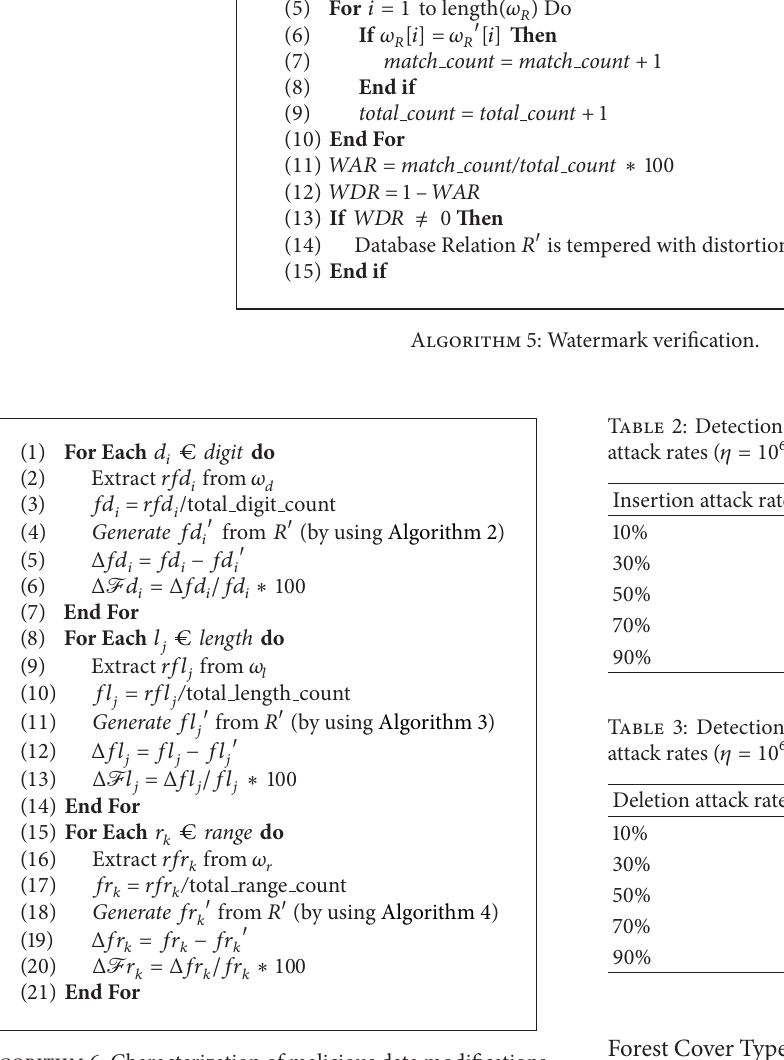
Algorithm 6: Characterization of malicious data modifications.